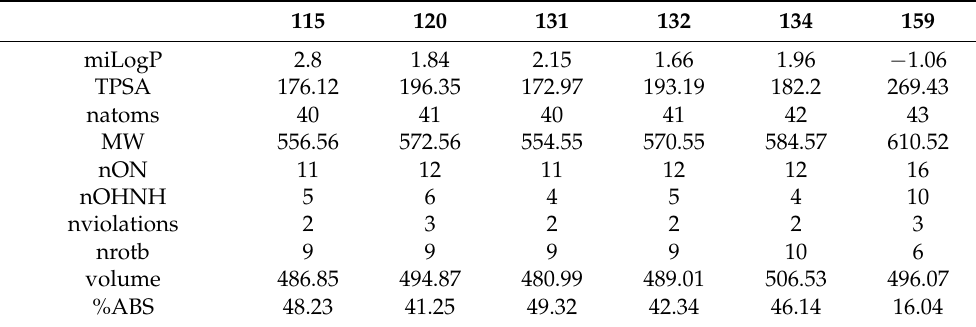
Table 2. Drug-likeness and molecular properties of top scoring compounds predicted at molinspira- tion server. miLogP: Molinspiration LogP (Octanol-water partition coefficient); TPSA: Total polar surface area (drug transport properties); natoms-Number of atoms; Mol.Wt (g/mol): Molecular weight; nON: number of hydrogen bond acceptors; nOHHN: number of hydrogen bond donors; nviolations: Number of Lipinski’s rule of five parameters violations; nrotb: Number of Rotatable Bonds (molecular